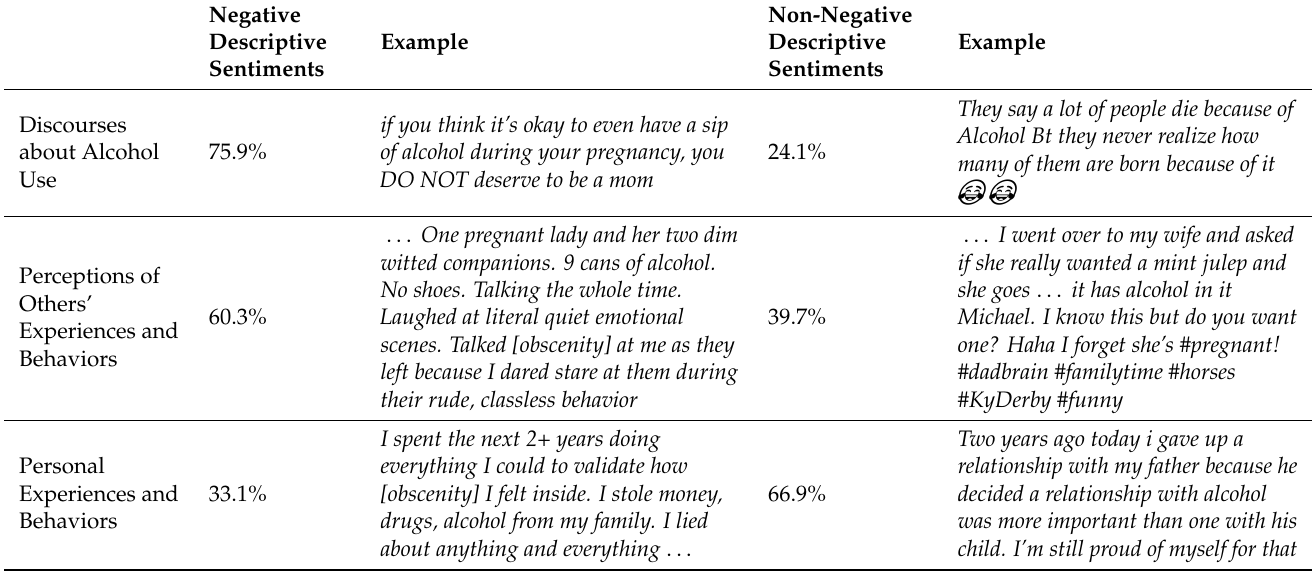
Table 2. Frequency of Descriptive Sentiments in Relation to Narrative Position.